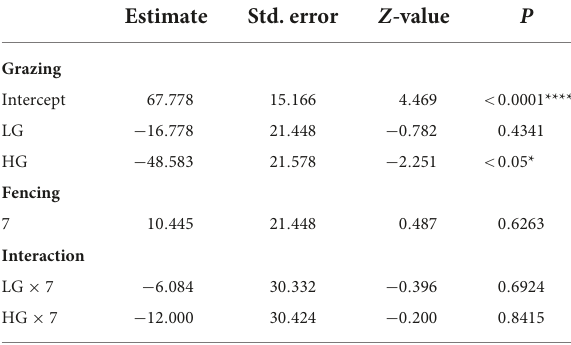
TABLE 2 Results of generalized linear mixed models (GLMMs) for species abundance of insects sampled after 3 or 7 fencing years in three grazing treatments in a desert steppe: Ungrazed plot (CK, used as reference), light grazed (LG), and heavily grazed (HG). Estimate Std. error Z -value P